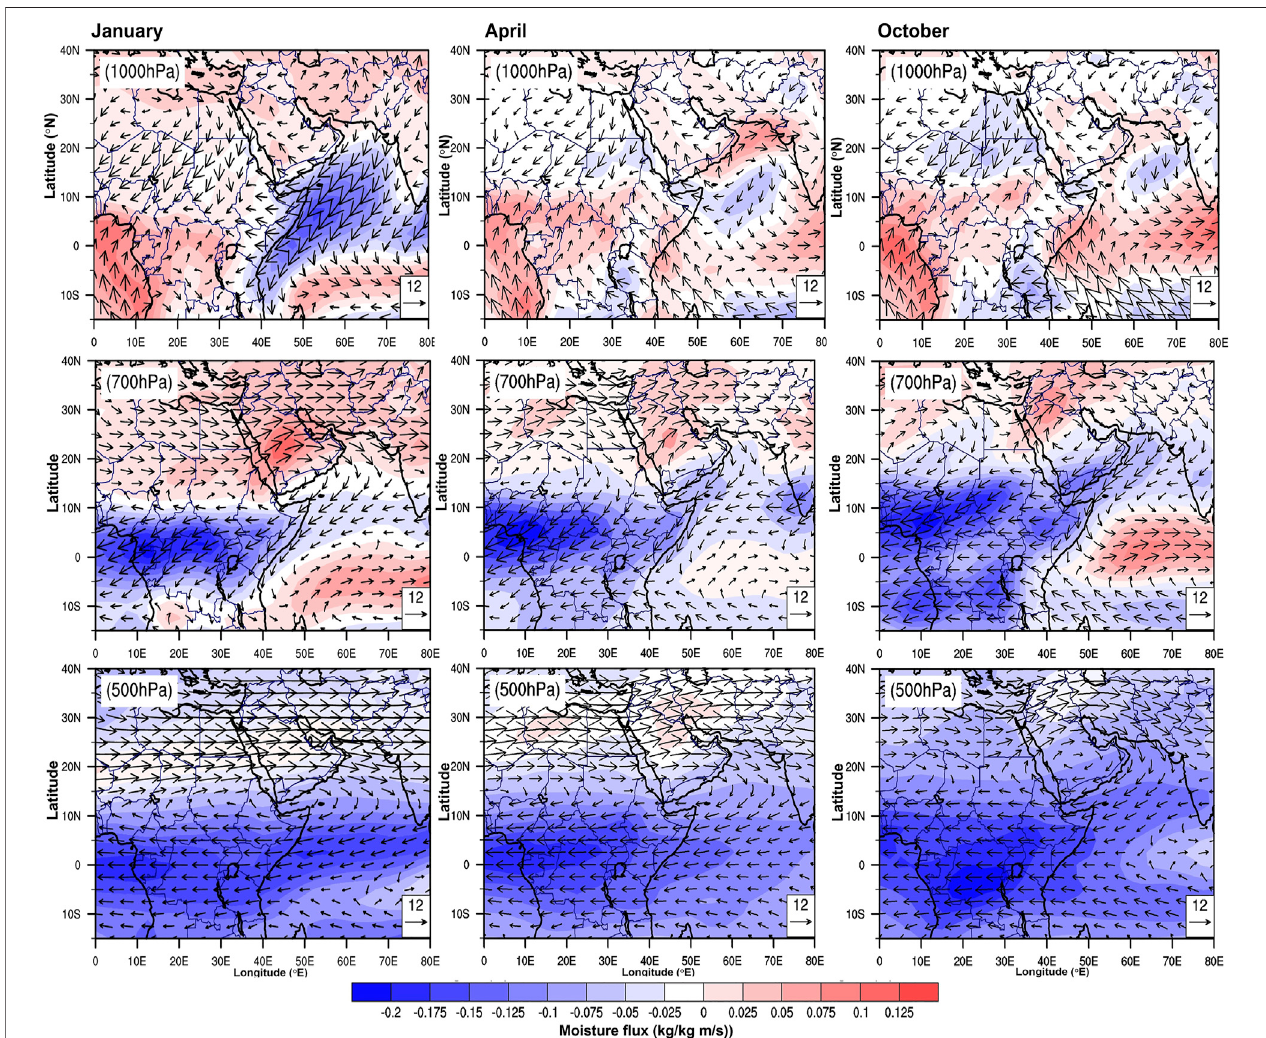
FIGURE 10 | The spatial distribution of moisture fl ux (qv) and wind vector in three different pressure levels over 3 months (e.g., 1,000, 700, and 500 hPa).